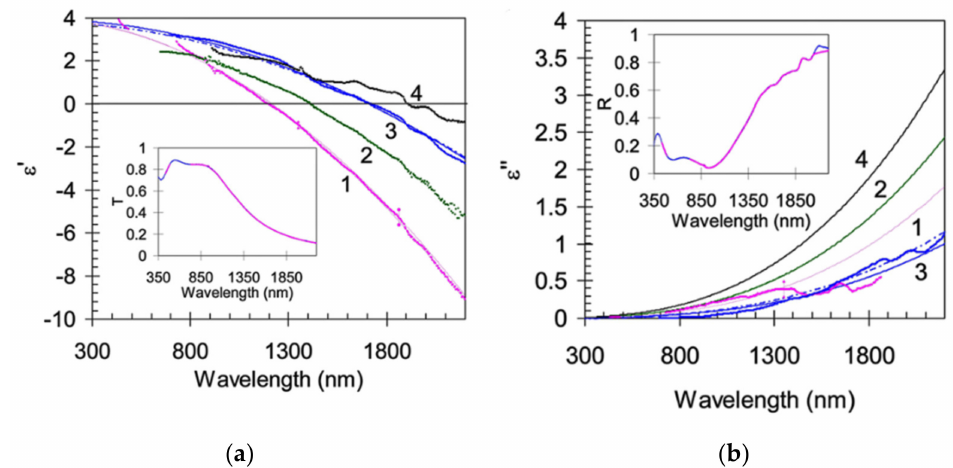
Figure 14. Experimental spectra of real ( a ) and imaginary ( b ) parts of electric permittivity. ITO (1), ZITO (2), AZO (3), and ITZO (4). Reproduced with permission from [266].